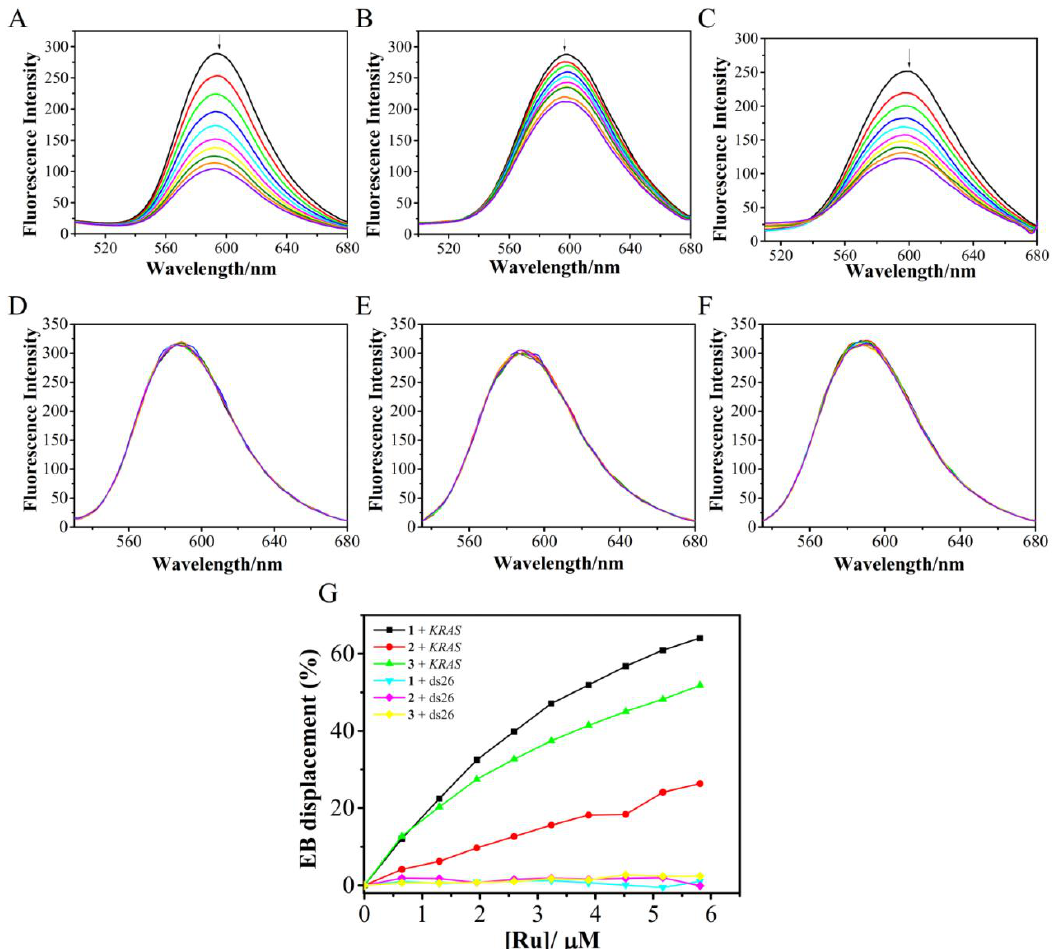
Figure 3. Emission spectra of ethidium bromide DNA (EB-DNA) in the incubation buffer in the absence and presence of complexes. ( A – C ) EB- KRAS G4 DNA and ( D – F ) EB-ds26 DNA. [EB] = 16 µ M, [ds26 DNA] = 2 µ M, [ KRAS G4 DNA] = 2 µ M. ( G ) Changes in EB displacement rate with the increasing concentrations of complexes in the EB-DNA